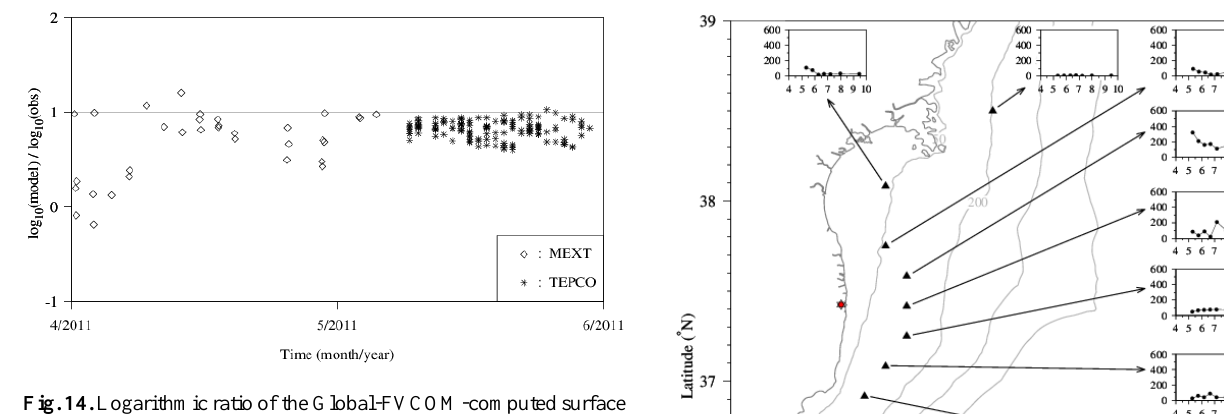
Fig. 14. Logarithmic ratio of the Global-FVCOM-computed surface 137 Cs concentration to the observation at MEXT and TEPCO mea- surement sites during April and May 2011.